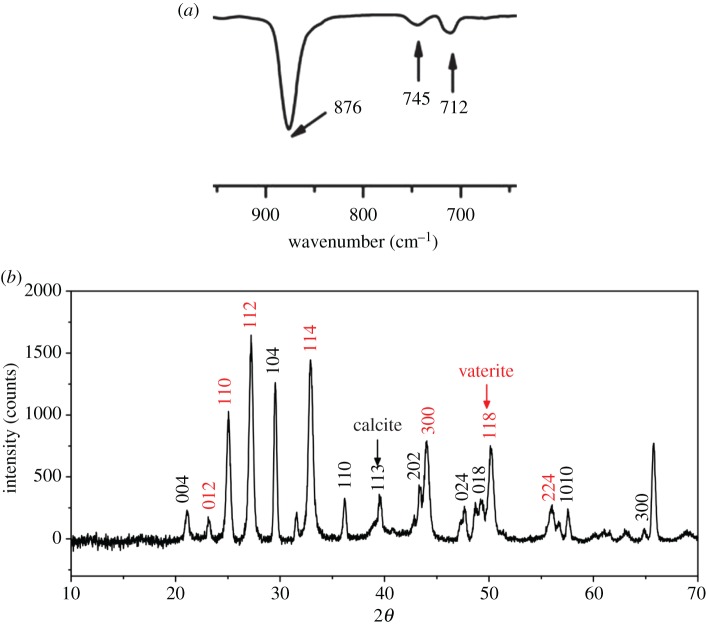
FTIR spectrum (a) and XRD pattern (b) of CaCO3 microspheres.